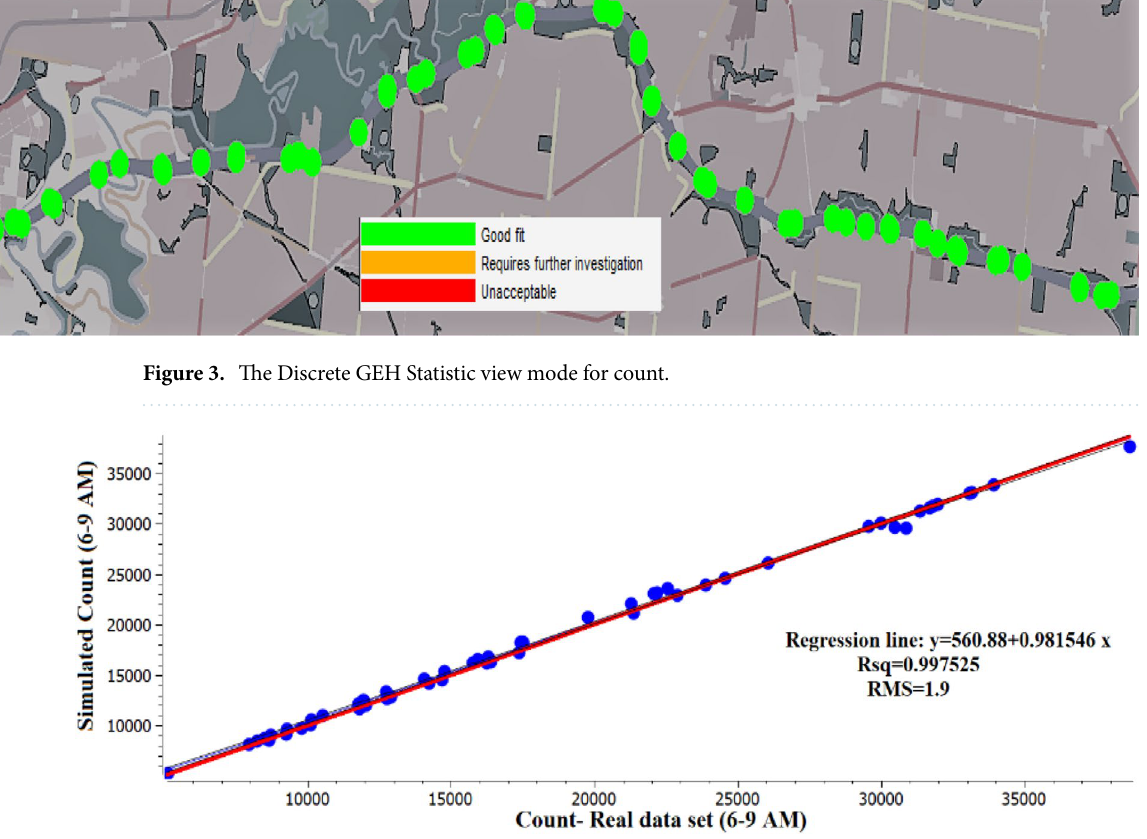
Figure 4. Regression analysis of the real data set for count vs simulated